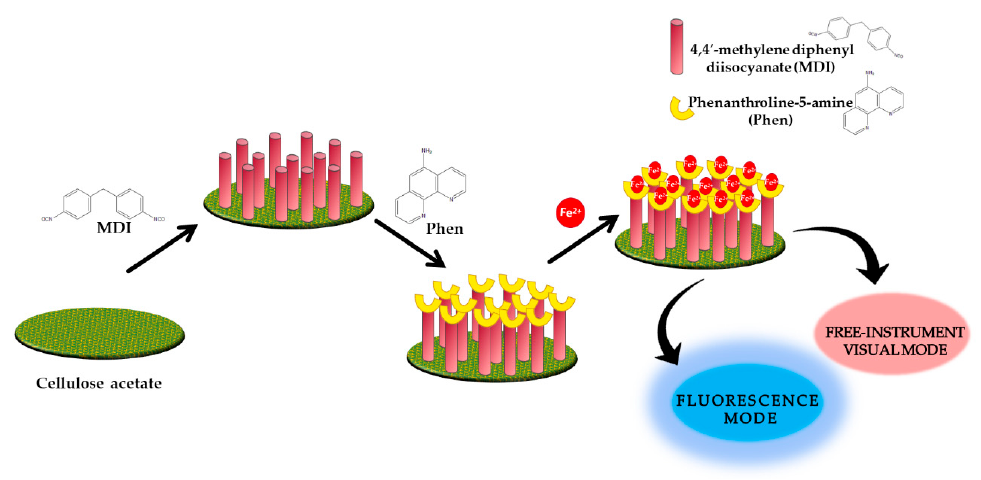
2 + by Phen-MDI-cellulose based on multimode sensors Figure 3. Detection strategy of Fe 2+ by Phen-MDI-cellulose based on multimode sensors [59]. Figure 3. Detection strategy of Fe